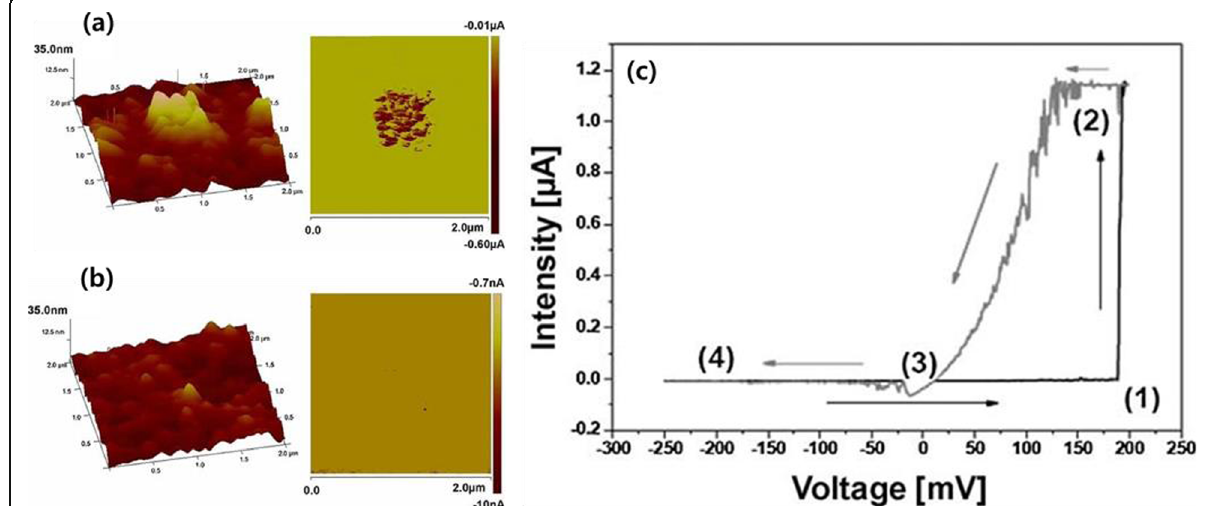
Fig. 2 Surface morphology changes in the switching layer when voltage is applied to a film via C-AFM. a The surface of an Ag/Ge 0.25 Se 0.75 film applied with + 200 mV (V wr ) shows images of local morphology (left) and 2D current mapping (right). b The surface of an Ag/Ge 0.25 Se 0.75 film applied with − 250 mV (V er ) shows images of local morphology (left) and 2D current mapping (right). c I-V curves: (1) writing step, (2) on-state, (3) erasing step, and (4) off-state. Reprinted from Pradel et al. (2011) ( Phys. Status Solidi A 208, 2303 – 2308) with Physica Status Solidi A ’ s